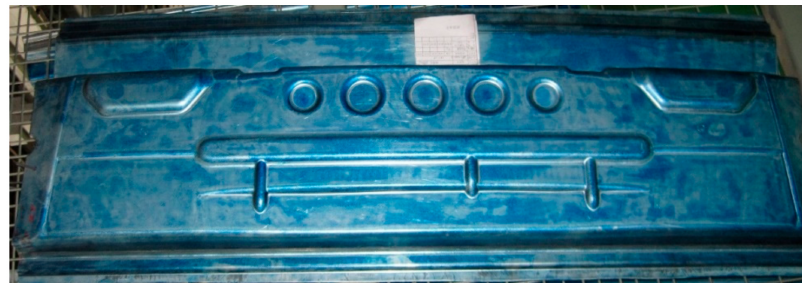
Figure 12. Automobile component.